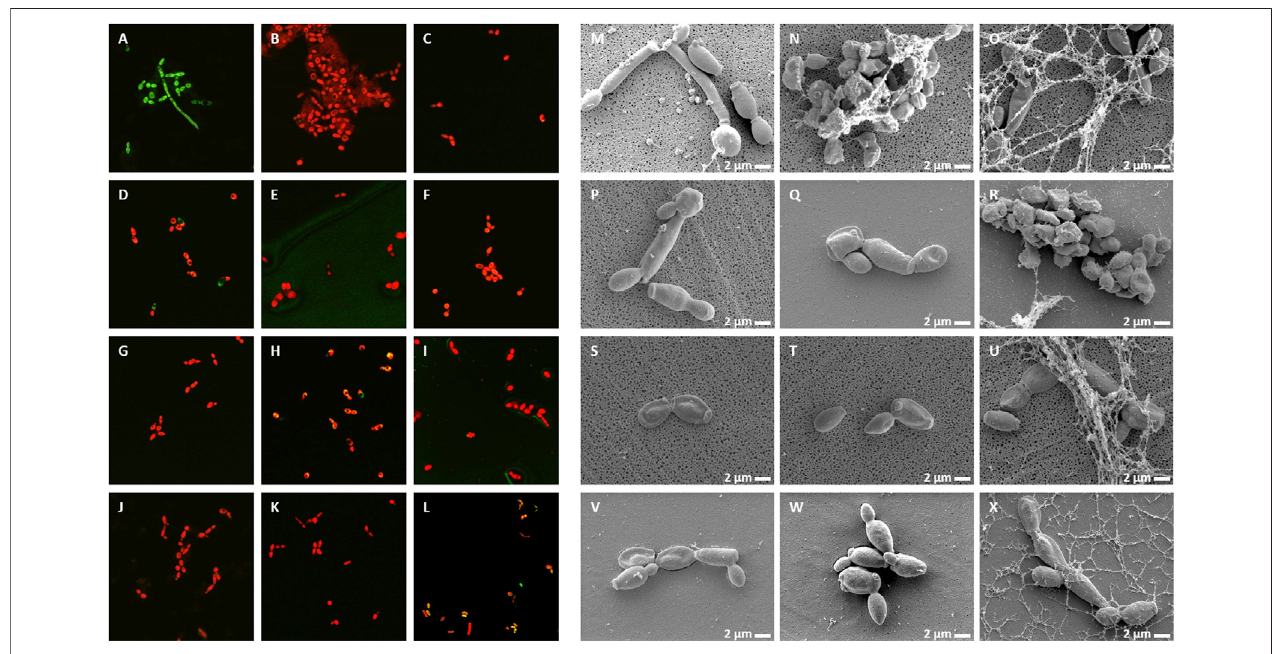
FIGURE 4 | Viability, membrane permeability and morphology of C. albicans cells after NCR treatment (A – L) SYTO9/PI staining observed with confocal microscope, (M – X) CellmorphologyobservedwithSEM (A,M) untreatedcontrol, (B,N) CaNCR13,3.125µM, (C,O) CaNCR63, 3.125µM, (D,P) CaNCR63 1-20 ,25 μ M, (E,Q) CaNCR63 15-34 , 3.125 µM, (F,R) MsNCR443, 3.125 µM, (G,S) MsNCR463 16-35 , 1.6 µM, (H,T) MsNCR463 17-30 , 1.6 µM, (I,U) PsNCR349, 1.6 µM, (J,V) PsNCR349